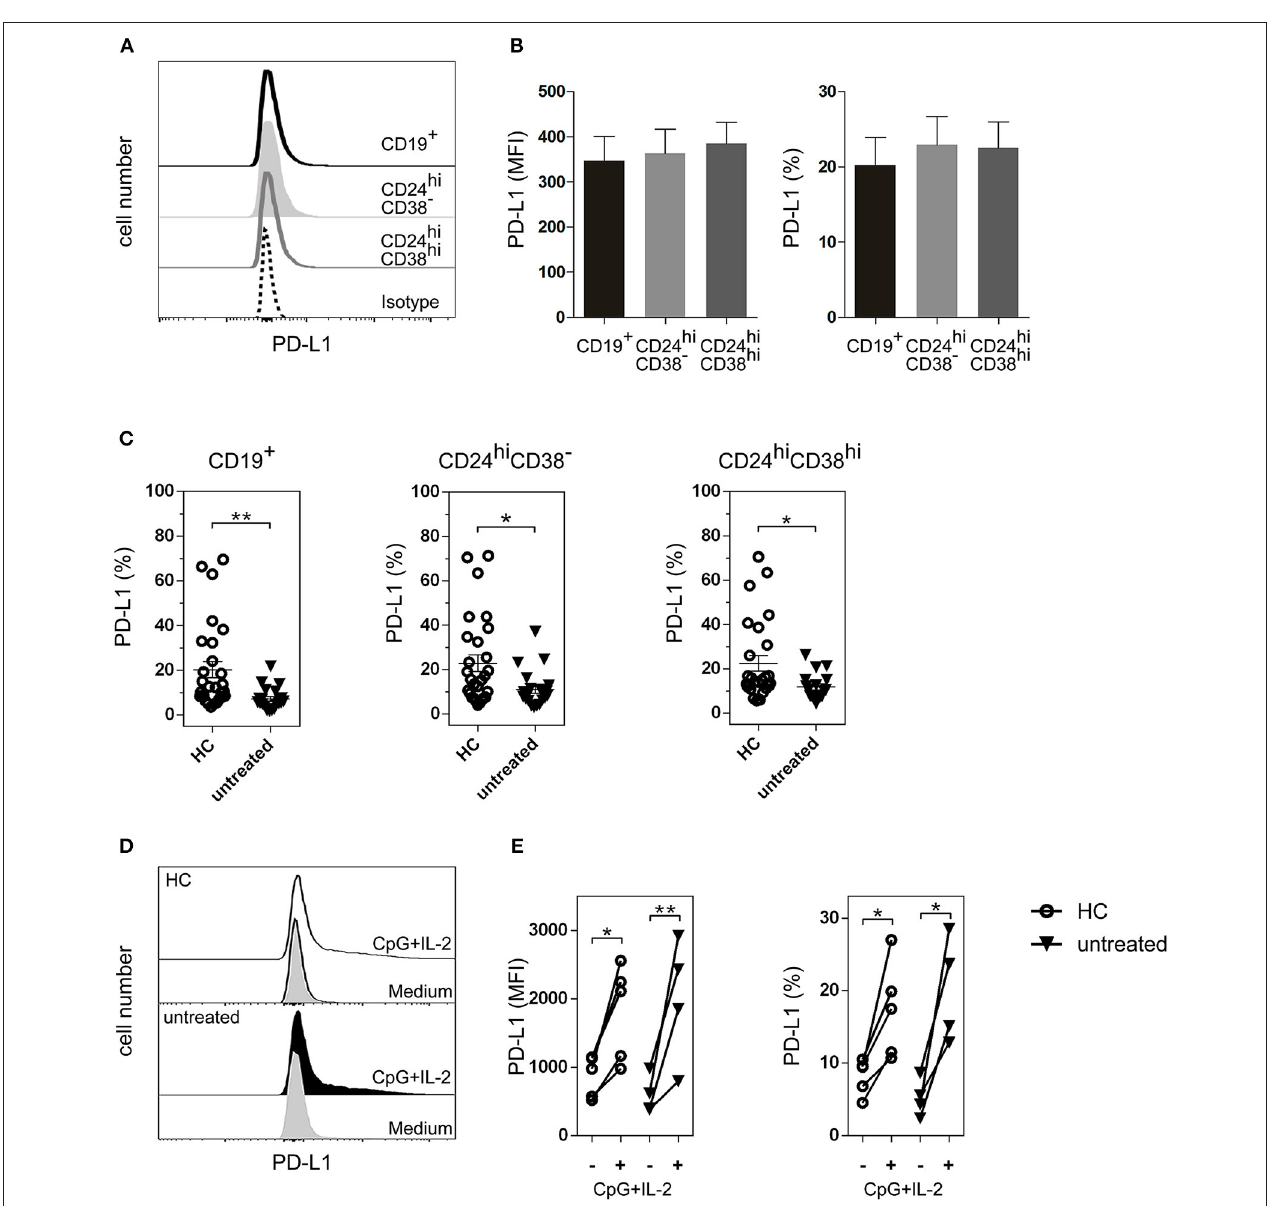
FIGURE 4 | PD-L1 + B cell subsets in HC and untreated RA patients. (A) Representative histogram of PD-L1 expression on total CD19 + B cells and on CD24 hi CD38 − and CD024 hi CD38 hi B cell subsets from HC. (B) Expression (mean fluorescence intensity (MFI) left panel and frequency, right panel) of PD-L1 on B cell subsets from peripheral blood of HC ( n = 25). Data are expressed as mean ± SEM. Kruskal-Wallis test with Dunn’s correction were used. (C) Frequency of CD19 + PD-L1 + B cells, CD24 hi CD38 − PD-L1 + and CD24 hi CD38 hi PD-L1 + B cell subsets from HC ( n = 25) and untreated RA patients ( n = 24). Data are expressed as mean ± SEM. ** p < 0.01. P values were determined using the Mann-Whitney Test. ( D) Representative histograms of PD-L1 expression on total CD19 + B cells purified from PBMC of HC and untreated RA patient after 72h of incubation with CpG + IL-2 or with medium alone. (E) Expression (MFI, left panel and frequency, right panel) of CD19 + PD-L1 + B cells purified from PBMC of HC ( n = 5) and untreated RA patients ( n = 4) after 72h of incubation with CpG + IL-2 or with medium alone. Data were collected from five independent experiments. * p < 0.05, ** p < 0.01. P values were determined using the Student’s t -test for paired